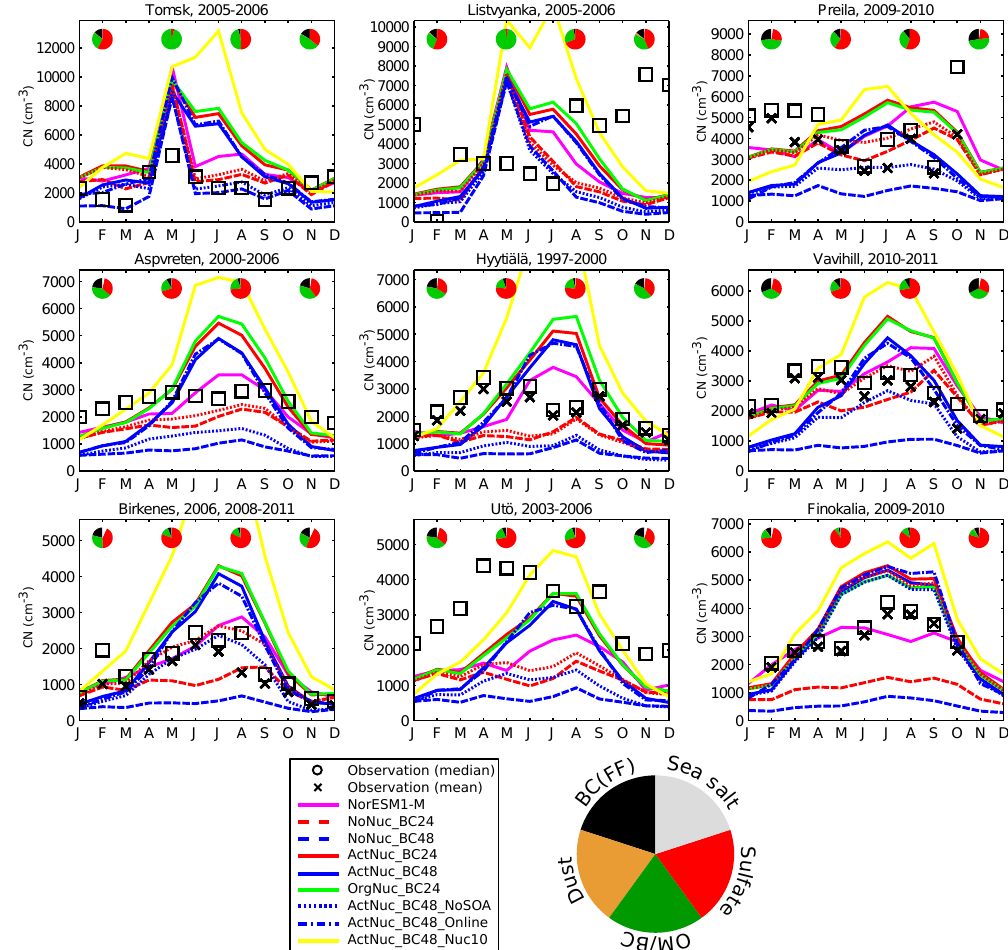
Figure 9. As Fig. 5, but for remote sites.